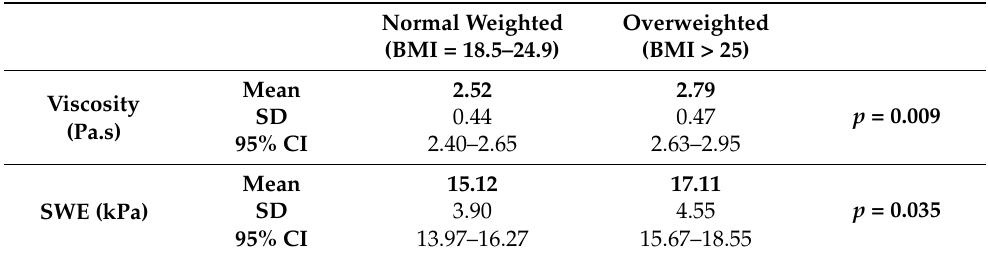
Table 6. Mean viscosity and stiffness values of the thyroid parenchyma in the healthy volunteers group according to BMI.